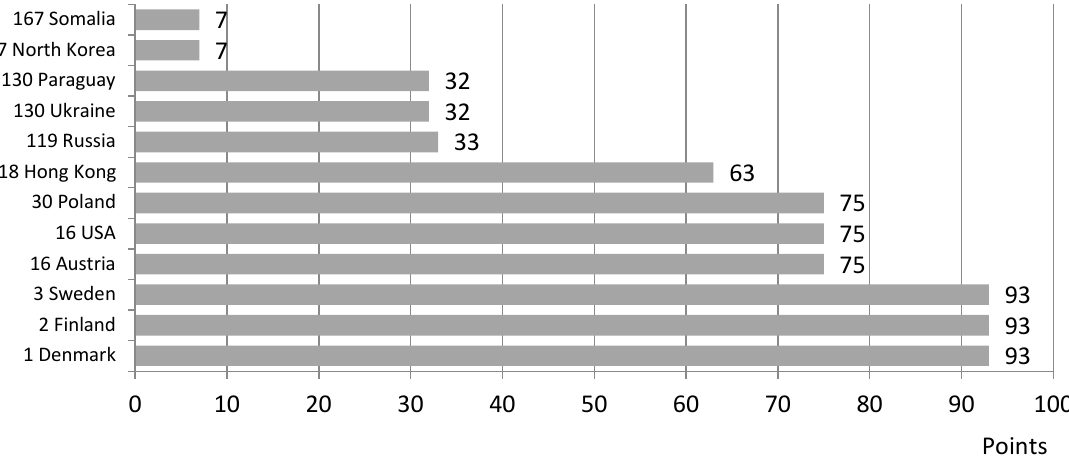
Figure 1. Rating of certain states with different CPI